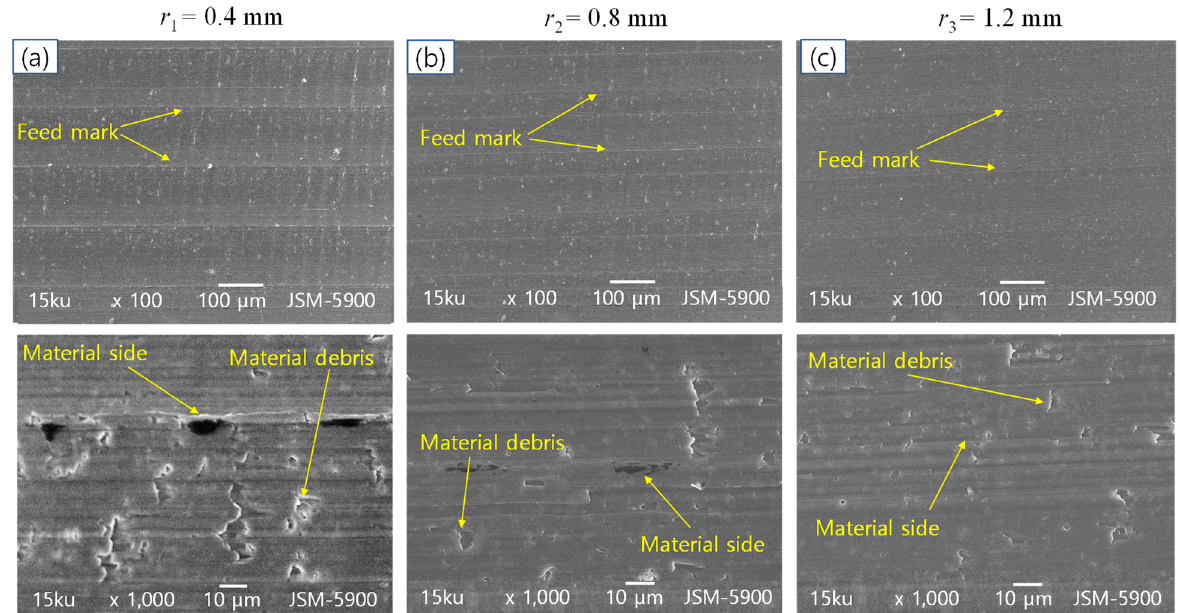
Figure 8. Micro-image of machined surface for tool nose radii of ( a ) r 1 = 0.4, ( b ) r 2 = 0.8 and ( c ) r 3 = 1.2 mm at 100× and 1000× magnifications (SEM) with a combination of cutting parameters 710 rpm and 0.209 mm/rev.